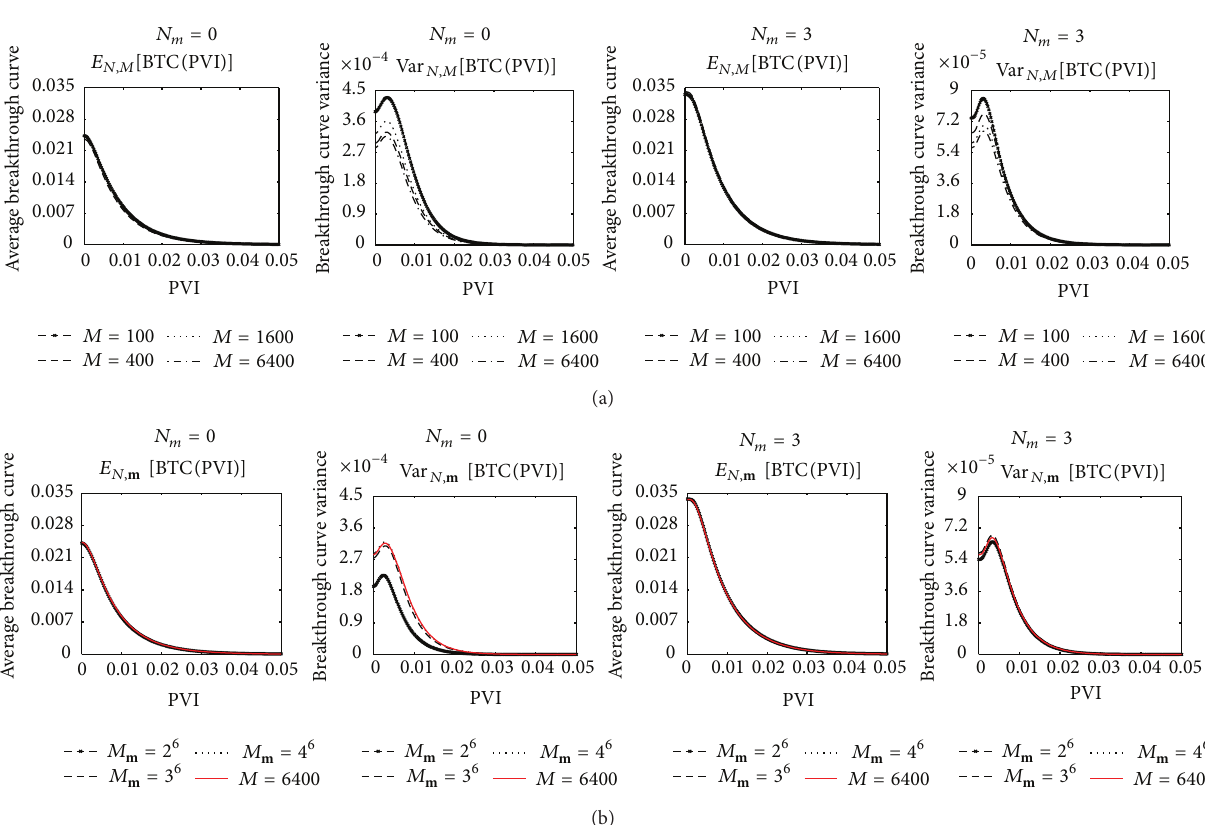
Figure 12: Moments of the breakthrough curves approximated by KL-MC method (a) and KL-SC (b) with 𝑁 = 6 and varying 𝑀 and m , respectively.